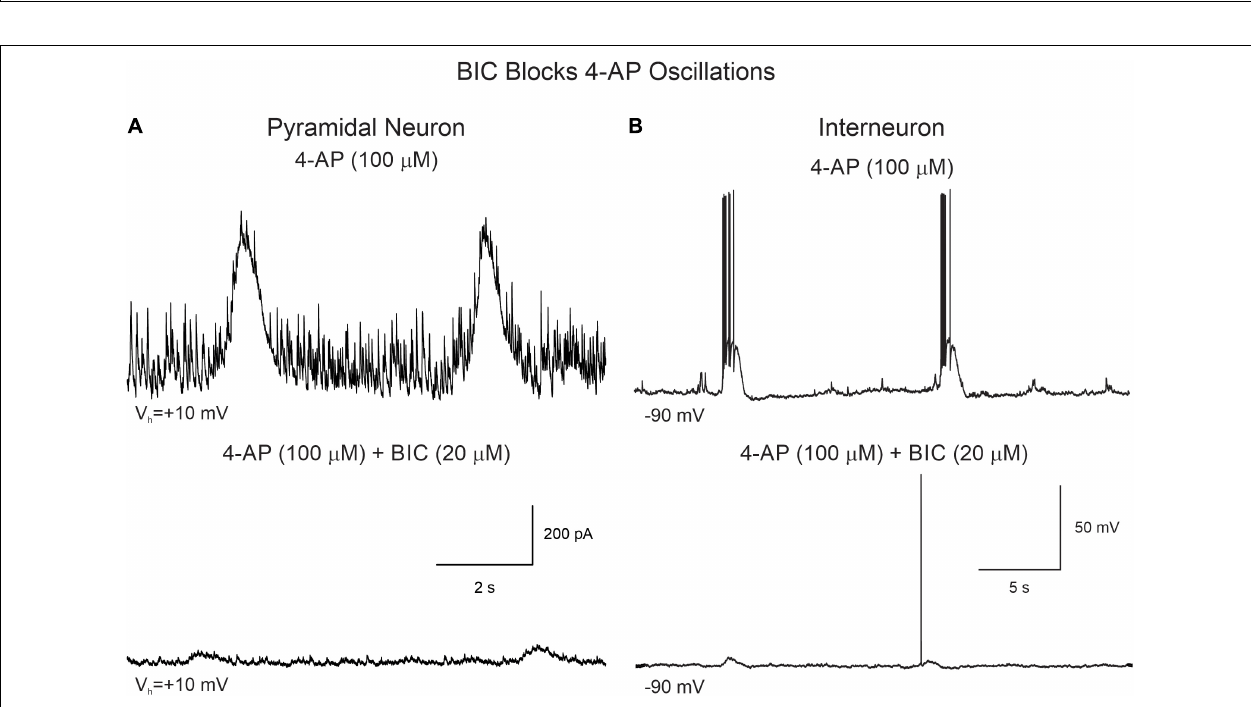
FIGURE 5 | BIC reduces the amplitude of 4-AP oscillations in CPNs and interneurons. (A) CPN recorded in voltage clamp mode (+10 mV holding potential). After stable 4-AP oscillations were induced (upper trace), bath application of BIC (20 µ M) significantly reduced the amplitude of the oscillations (lower trace). (B) 4-AP oscillations and bursting were induced in this interneuron recorded in current clamp mode. The cell was hyperpolarized to − 90 mV by injecting negative current to prevent spontaneous firing. After BIC application, membrane depolarization amplitude and bursting were reduced.